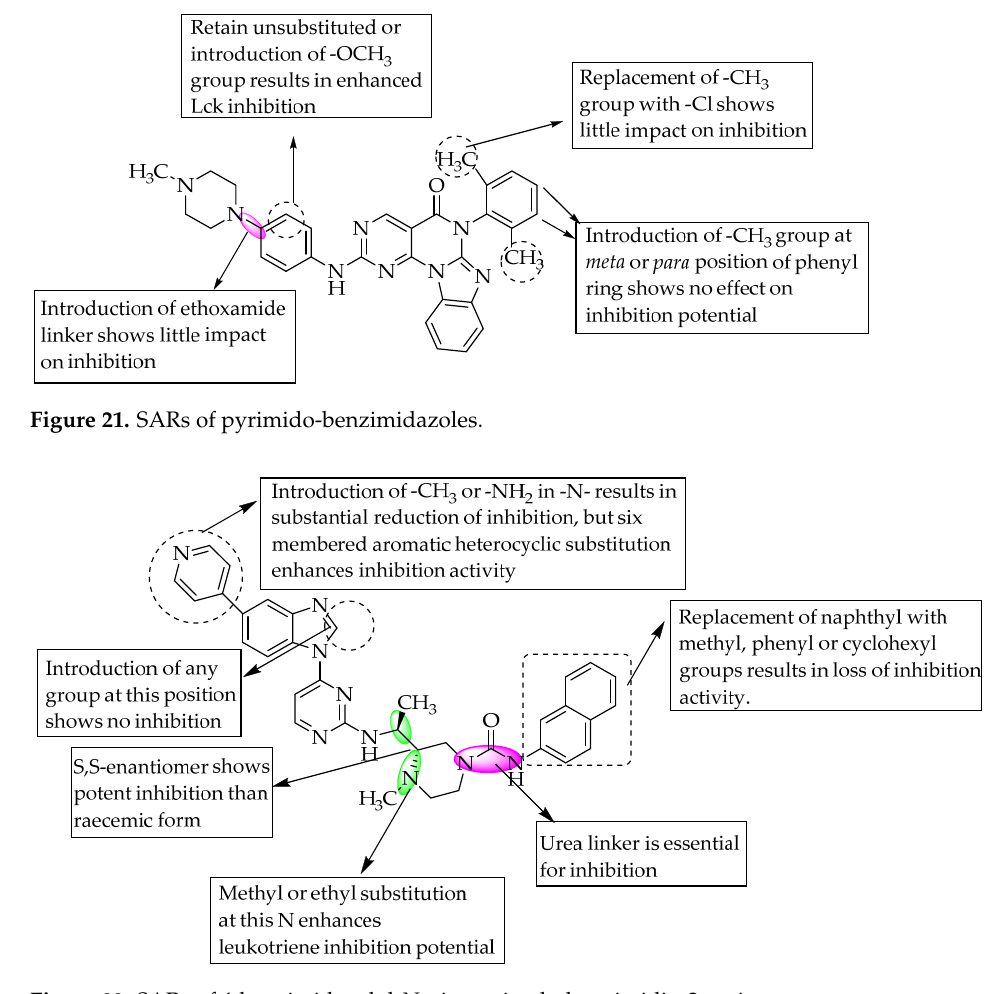
Figure 22 . SARs of 4-benzimidazolyl- N